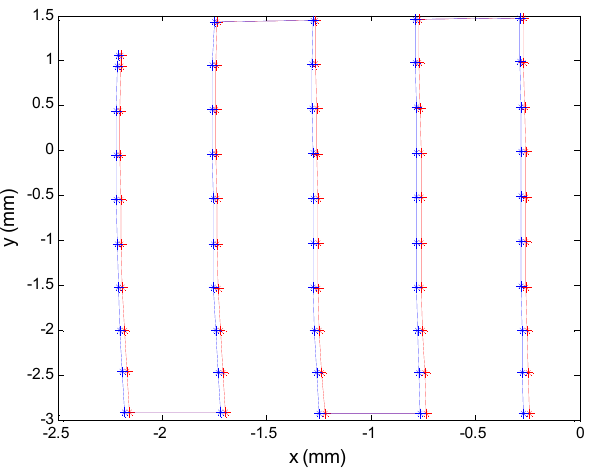
Figure 22. Points obtained from PSD signals using resistors with a tolerance of 0.1% and capacitors with a tolerance of 2%. Points corrected after calibration are shown in blue.